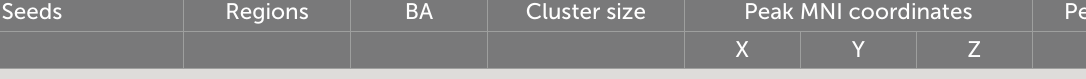
TABLE 3 Diagnosis and childhood trauma effects on functional connectivity of anterior cingulate cortex (ACC) subregions. Seeds